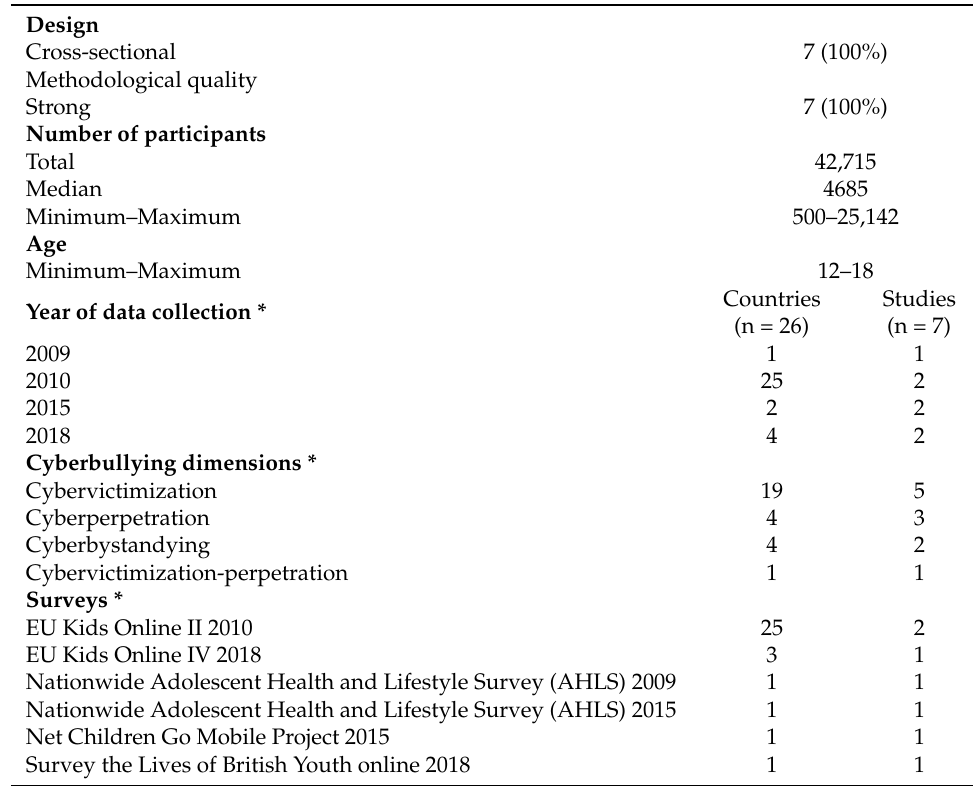
Table 1. Summary of study